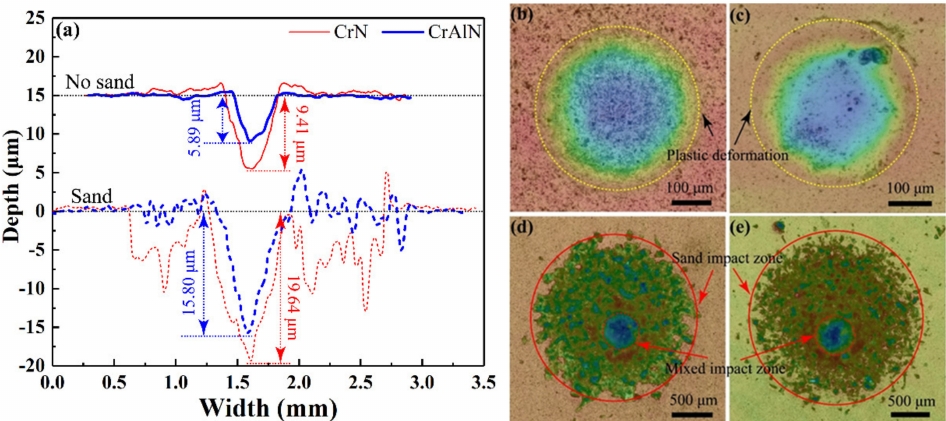
Figure 8. Impact wear scar profile and surface cloud chart of CrN and CrAlN coating under RT in sand and no − sand condition: ( a ) Wear scar profile; ( b , d ) CrN coating in sand and no-sand condition; and ( c , e ) CrAlN coating in sand and no-sand condition.